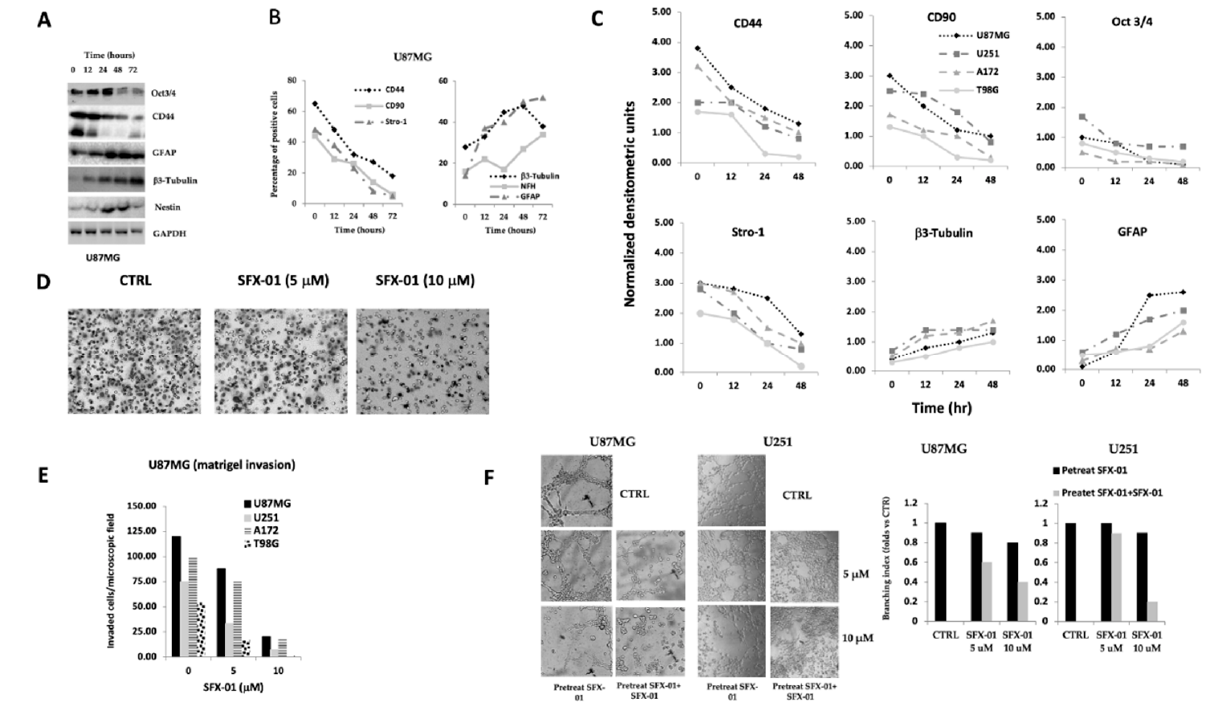
Figure 4. SFX-01 reduces PNT through the reduction of mesenchyme markers and induction of differentiated ones. ( A ) Representative western blots performed on U87MG cell extracts: Time-dependent modulation of CD44, Oct3/4 (mesenchymal/stem cell markers), β 3-tubulin, nestin, and GFAP (differentiated markers). ( B ) Representative FACS analysis: Time-dependent modulation of CD44, Stro1, and CD90 as MES/stem cell markers; β 3-tubulin and neurofilaments (NF200) as neural markers; and GFAP as an astrocyte marker. ( C ) semi-quantitative analyses (normalized densitometric values obtained by ImageJ in western blots performed on cell extracts from U87MG, U251, A172 and T98G glioma cells. ( D ) matrigel invasion assay (representative pictures from U87MG cells) and ( E ) counts of invaded cells/microscopic field in U87MG, U251, A172 and T98G cells treated with 5 and 10 µ M SFX-01 ( F ) Analysis of vasculomimicry (VM) of U87MG (and U251, for comparison of more-differentiated cells) showed reduced Matrigel invasion by cells treated with 5 or 10 µ M SFX-01. Pre-treatment with SFX-01 decreased VM activity. Quantification of VM was performed by the evaluation of tubule structure and branching index calculation.